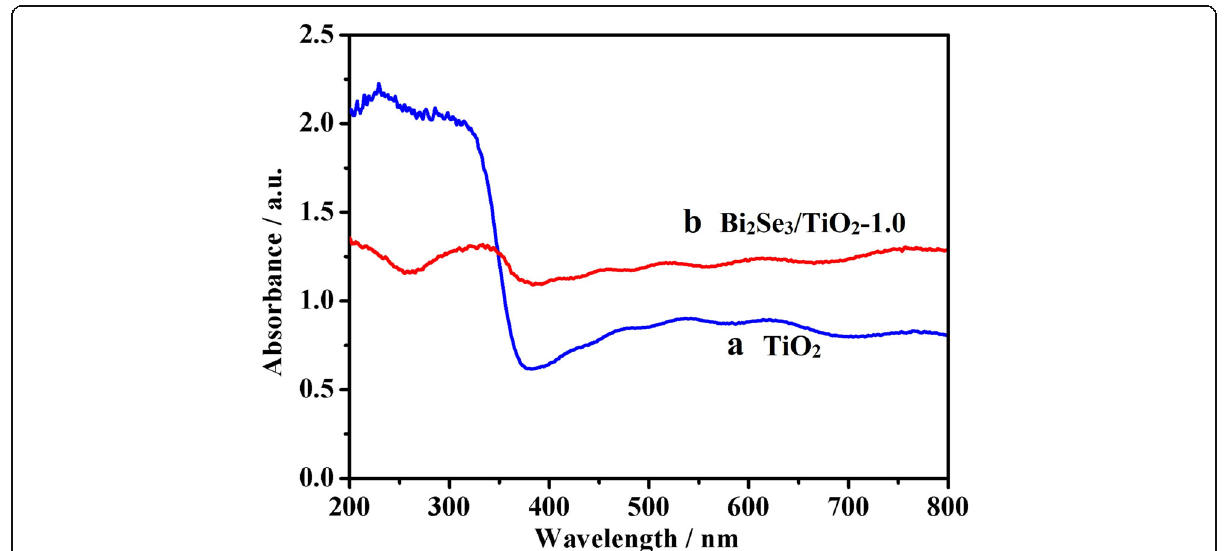
Fig. 4 UV-visible absorption spectra for TiO 2 (a) and Bi 2 Se 3 /TiO 2 -1.0